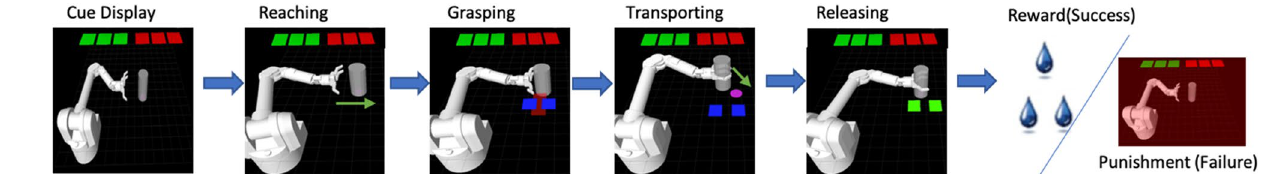
Figure 1. Cued grip force task. The behavioral task was composed of 6 scenes for each trial as described in the